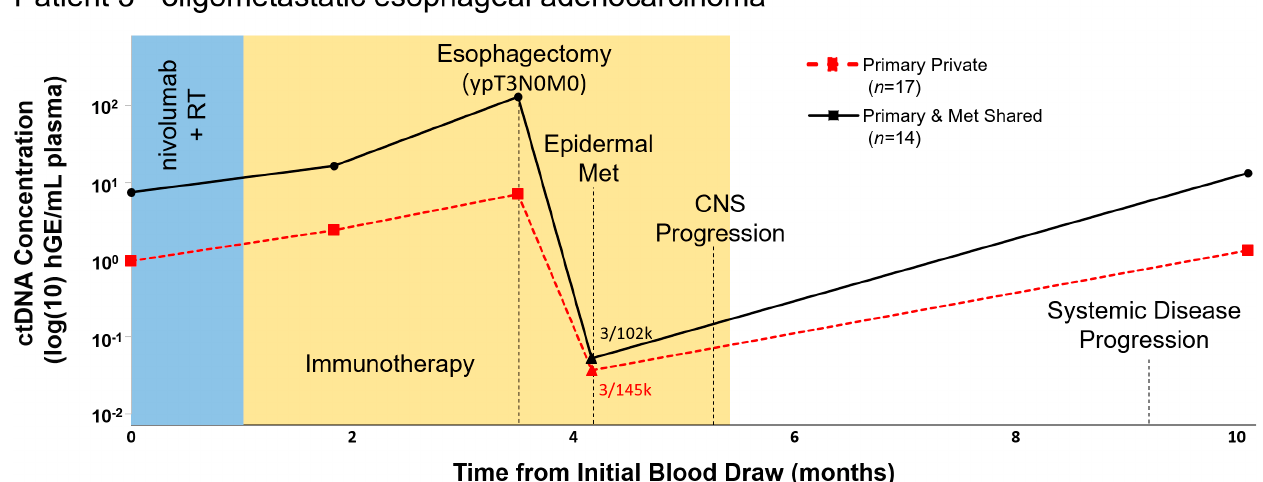
Figure 3. Oligometastatic esophageal adenocarcinoma cancer patient with primary-only oligoprogression had elevated ctDNA levels associated with systemic disease progression. In Patient 3, whole-exome sequencing of both the primary tissue biopsy and a subsequent metastatic dermal lesion revealed a high mutation burden and 45% overlap in mutation profiles. Serial ctDNA levels were retrospectively analyzed using DIDA-Seq and using patient-specific capture panels. Aggregate variant allele frequency (VAF) was converted to human genome equivalents per ml (hGE/mL) of plasma and plotted in log10-scale over treatment course. Plot shows ctDNA monitoring using mutations either private to the primary tissue biopsy ( n = 17, solid black line) or shared between the primary tissue biopsy and the biopsy of the metastatic dermal lesion ( n = 14, dashed red line). Statistical significance, as compared to a negative control, was determined at each time point. CtDNA values not significantly different from negative controls are indicated (triangle) and aggregate mutant reads/total reads are reported. Statistical significance was determined prior to converting aggregate VAF to hGE/mL plasma.